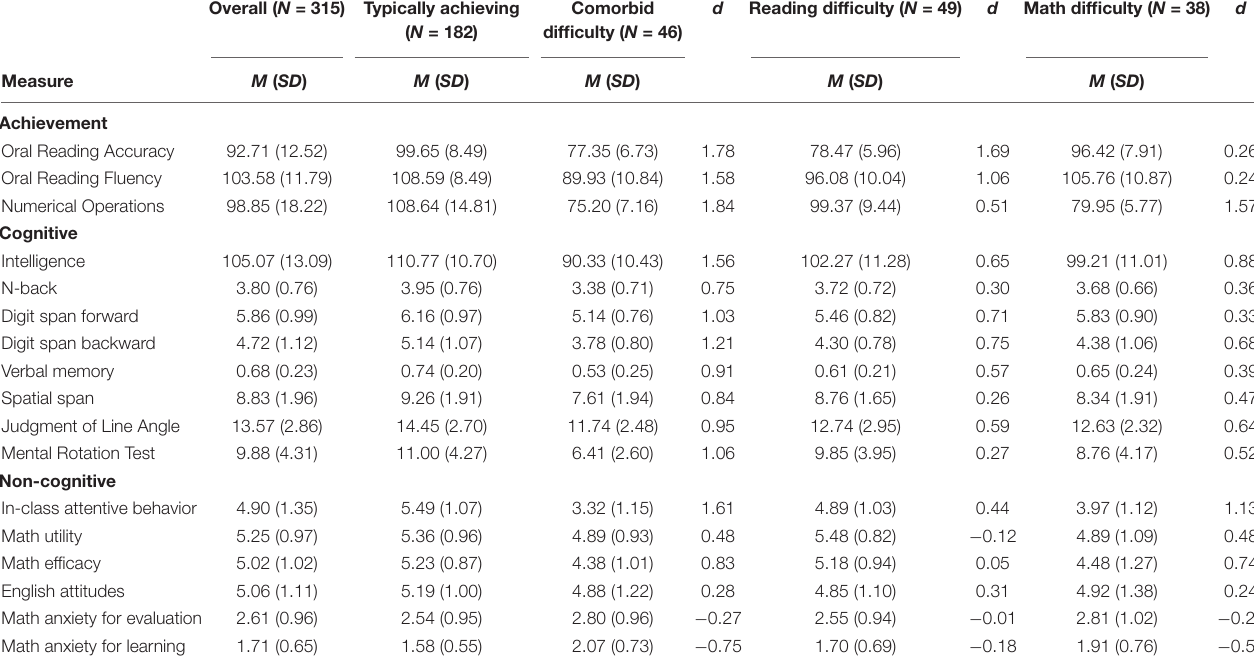
TABLE 2 | Means for cognitive and non-cognitive measures. Overall ( N = 315) Typically achieving Comorbid d Reading difficulty ( N = 49) d Math difficulty ( N = 38) ( N = 182) difficulty ( N = 46)